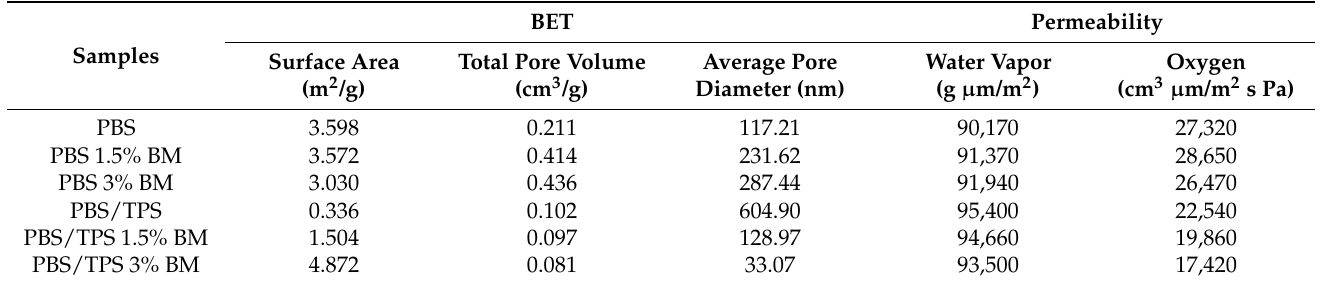
Table 4. BET, water vapor, and oxygen gas permeability data of PBS